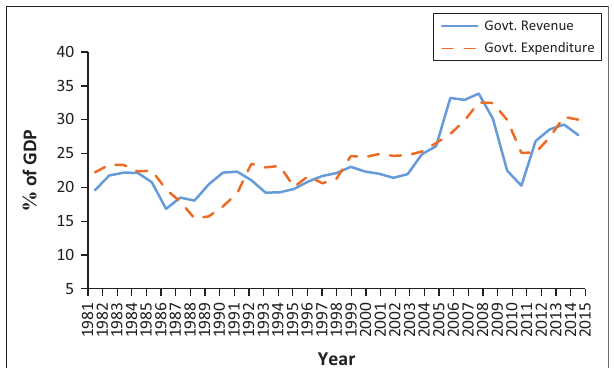
FIGURE 1: Government revenue and expenditure